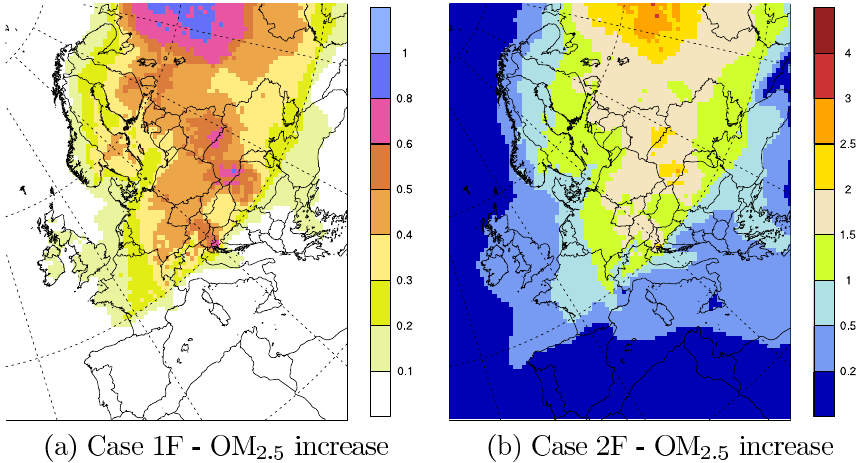
Figure 5. Potential increase of OM 2 . 5 (6-month mean, Apr–Sep) from increased biotic stress-induced emissions (SIE) in two “maximum” impact scenarios, compared to the corresponding current-situation model calculated concentrations. The concentration-difference fields il- lustrate potential effects of a changed climate that the northern/central European forests have not had time to adapt to; (a) Difference in OM 2 . 5 between Case 1F and Case 1 (SIE with only SQT), (b) Case 2F – Case 2 (SIE of both SQT and methyl salicylate). Unit: µgm − 3 . Note: Different colour